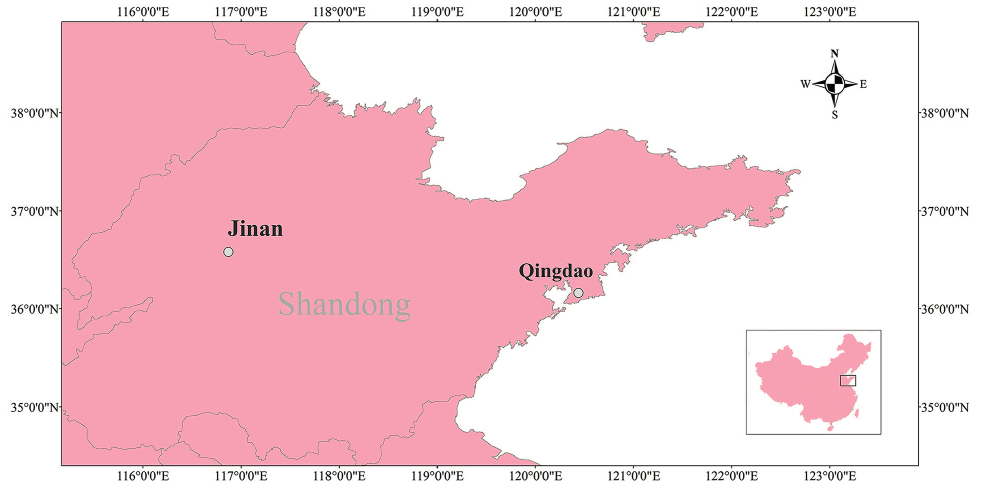
Figure 1. The geographical location of Jinan and Qingdao in Shandong province in China (map created with ArcGIS software,